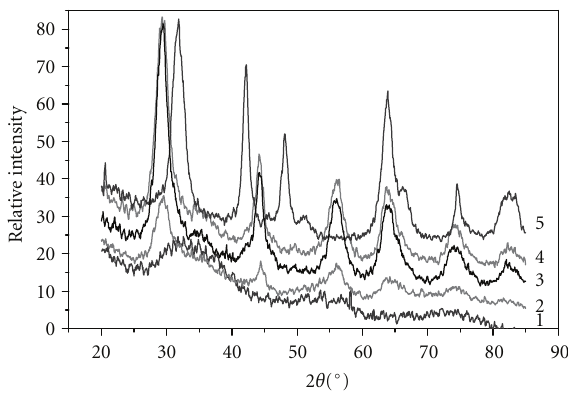
Figure 1: Di ff raction patterns of titanium dioxide samples of di ff erent structure: (1) X-ray amorphous, (2) brookite, (3) anatase (from TiCl 4 ), (4) anatase (from TIP), and (5) rutile.